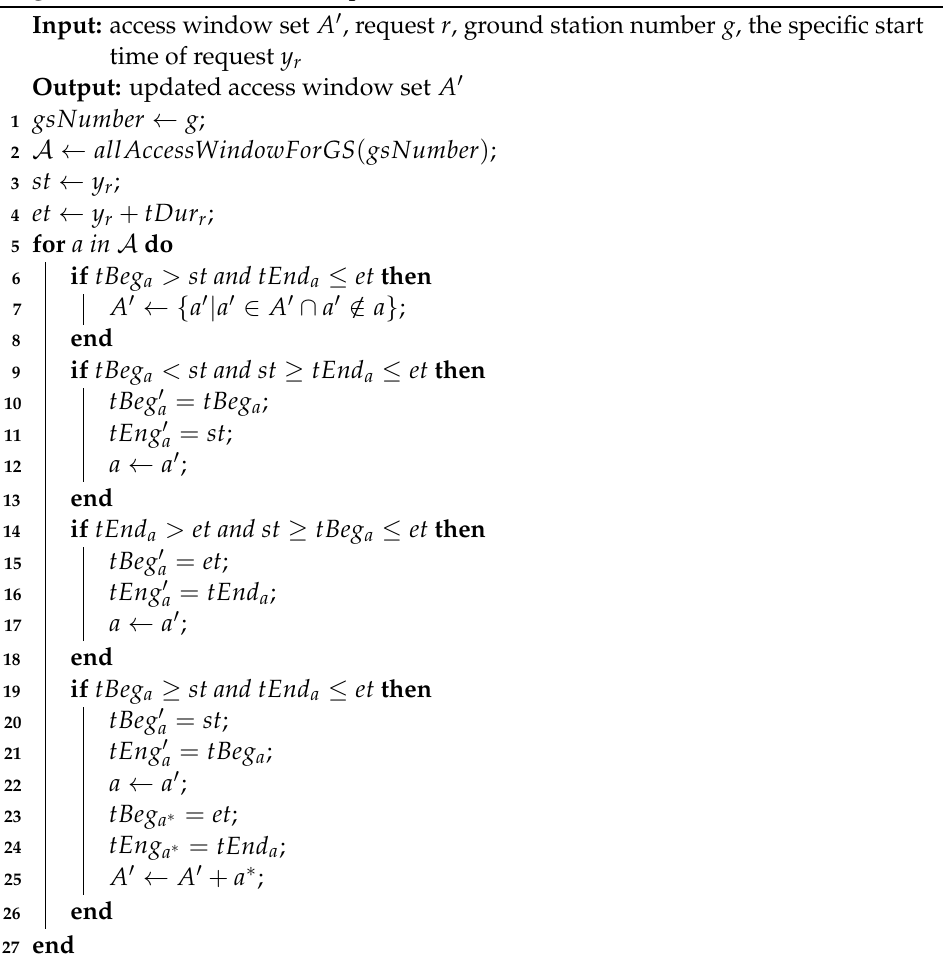
Algorithm 2: Access window update for DSA-RT and